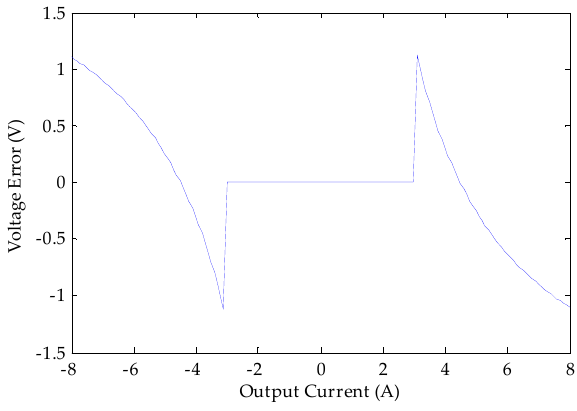
Figure 10. Average voltage error vs. output current in the calculation